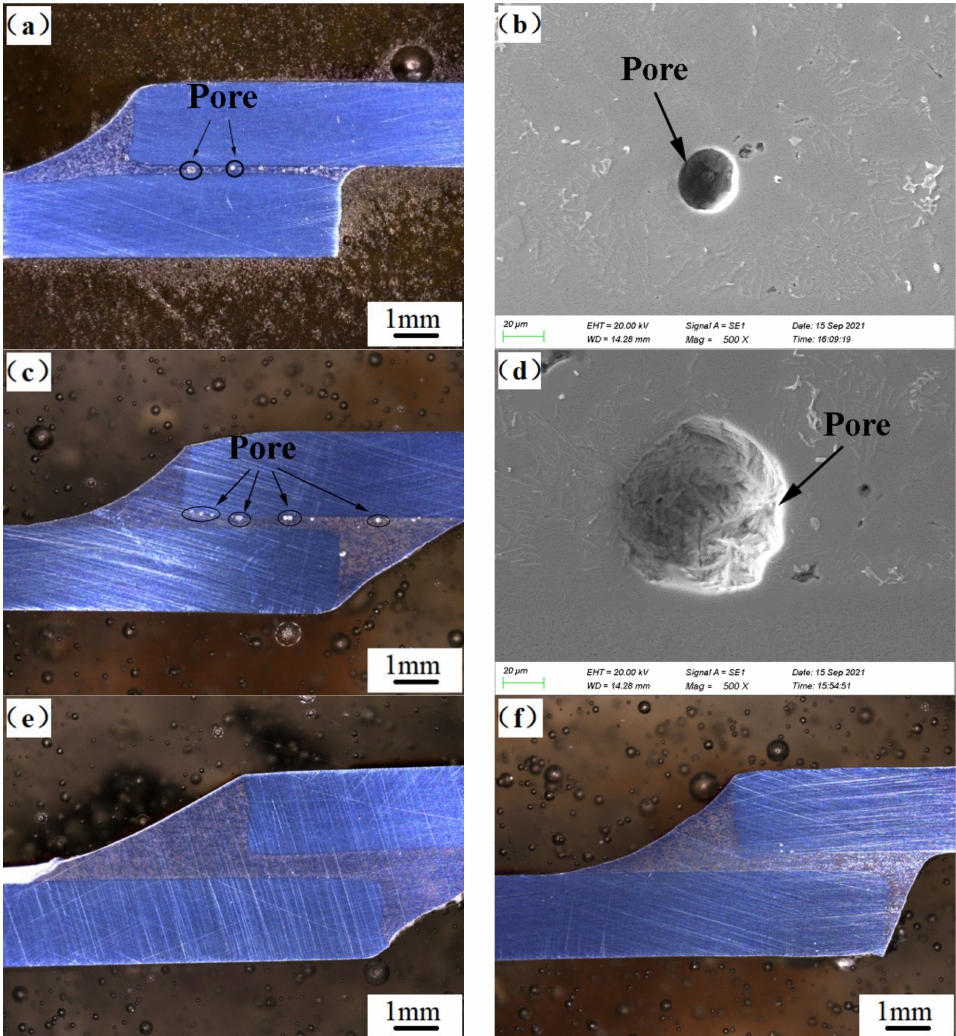
Figure 8. Cross-sections of brazed joints of different brazing filler metal: ( a ) The brazed joint of the SFC brazing filler metal damped for 3 days; ( b ) The micro morphology of pores in picture ( a ); ( c ) The brazed joint of the SKA brazing filler metal damped for 7 days; ( d ) The micro morphology of pores in picture ( c ); ( e ) The brazed joint of the PM brazing filler metal; ( f ) The brazed joint of the SKA brazing filler